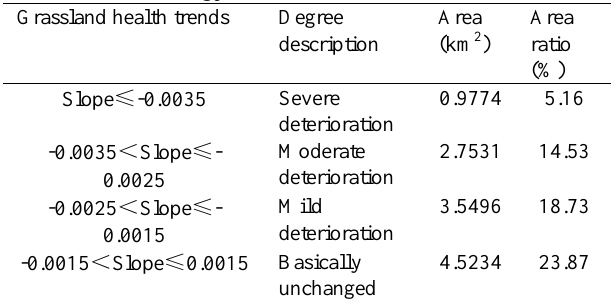
Table 4. Statistical analysis on the result of grassland health trends in Changji Prefecture between 2000 and 2016 Grassland health trends